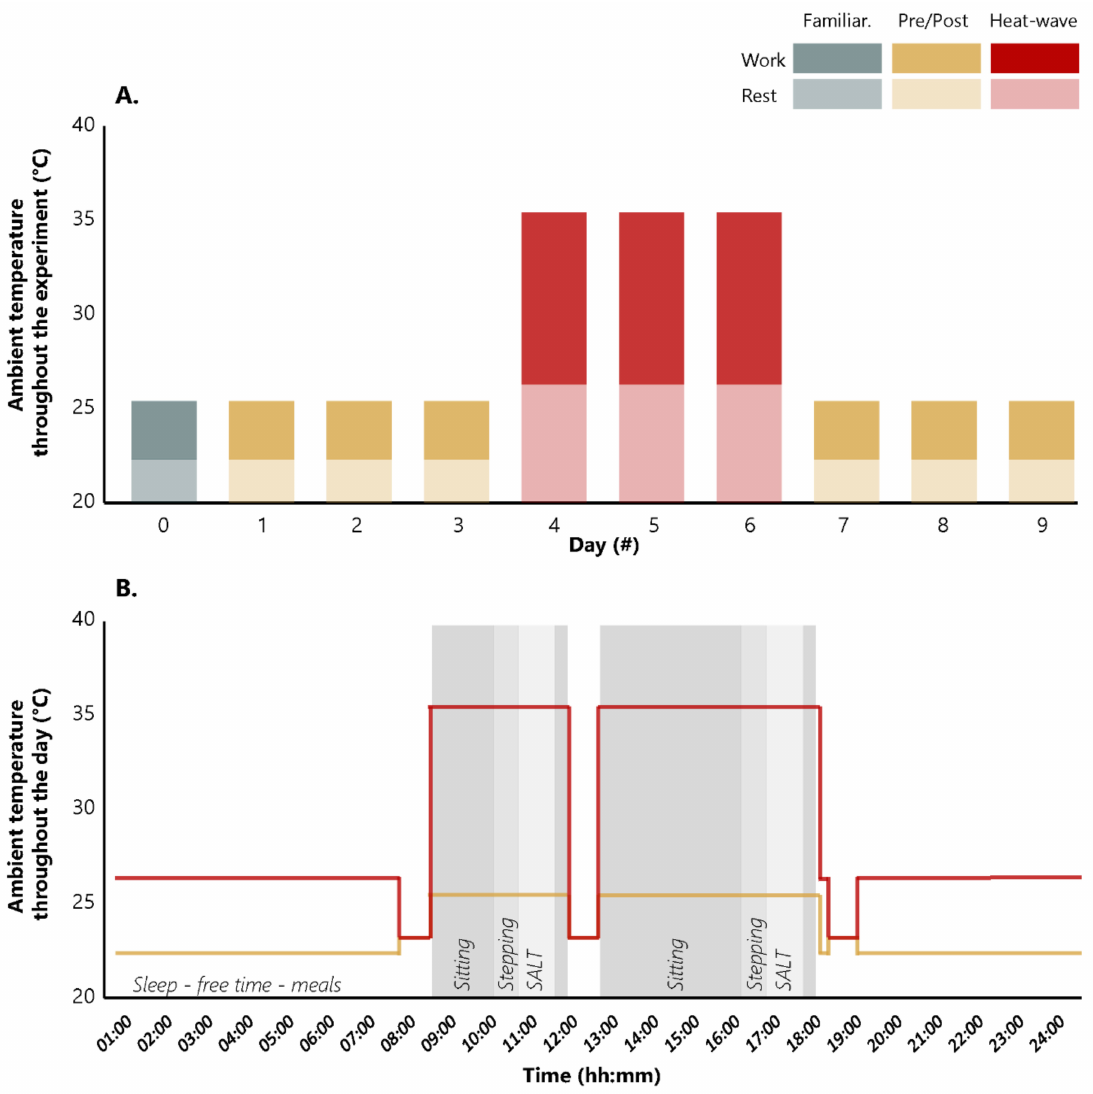
Figure 1. Fluctuation of simulated ambient temperatures throughout the experiment ( A ) and throughout the day ( B ). Turquoise, yellow, and red bars represent familiarisation day, pre/post, and during heat-wave periods, respectively. Dark and light colours correspond to the simulated ambient temperatures during work and rest, respectively. Lines represent the two levels (work and rest) of heat stress during (red) and pre/post (yellow) the simulated heat-wave. Work-shifts were scheduled between 08:40 and 18:00. A strict time-framed (wake up: 07:00, breakfast: 08:00, work: 08:40–12:00, lunch: 12:00, work: 12:40–18:00, dinner: 18:20, free time: 19:00–23:00, and sleep: 23:00) protocol was followed. The time periods spent on passive heat exposure (i.e., sitting in the workplace without having work to perform; duration, 5:20), simulated assembly line tasks (SALT; 2 × 60 min), and stepping sessions (2 × 40 min) are distinguished by different shades of grey. The remaining time was dedicated for meals, free time, and sleep in controlled environmental